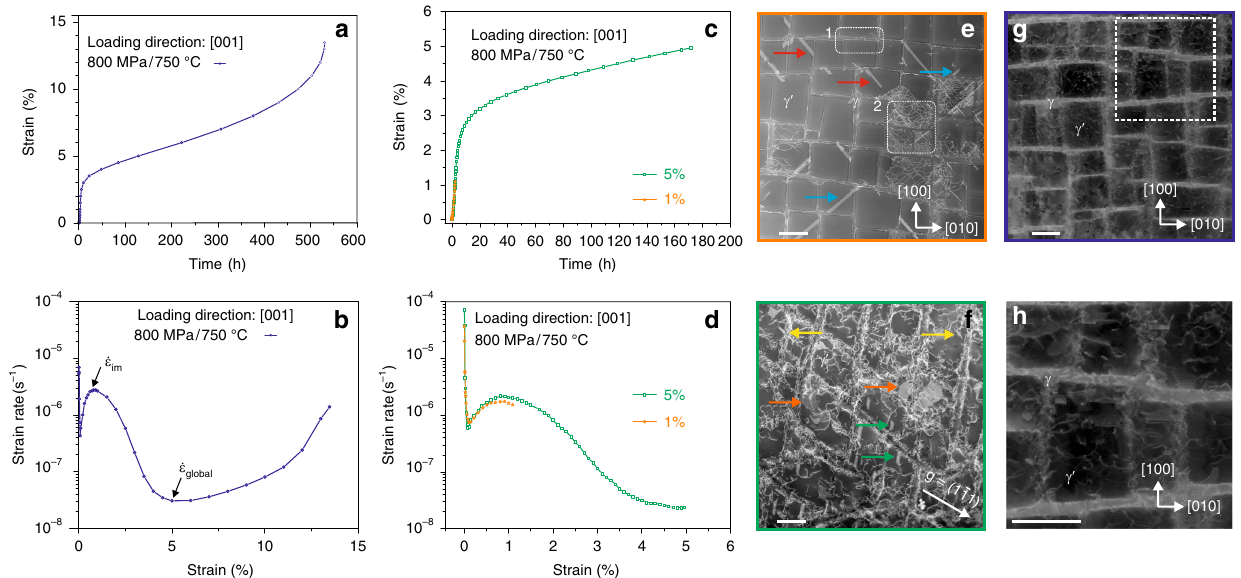
Fig. 1 Creep curves and microstructures for ERBO-1. Creep condition: 750 °C, 800 MPa, [001] orientation. a Strain vs. time till rupture. Rupture time: ~530 h. b Strain rate vs. strain till rupture. c Interrupted creep curves at 1 and 5%, strain vs. time. 1% creep time: ~1 h. 5% creep time: ~170 h. d Interrupted creep curves at 1 and 5%, strain rate vs. strain. e Representative STEM ADF overview of 1% creep strain, viewed in [001] zone axis. Region 1: region with low dislocation density; region 2: region with high dislocation density. Blue and red arrows show two types of SFs. f Representative STEM ADF overview of 5% creep strain under ( g ) condition of 1 (cid:2) 11 ð Þ , showing three different types of SFs, pointed by yellow, orange and green arrows. g ECCI overview of ruptured sample showing dislocations in the γ channel and SFs in the γ ′ phase. h Enlarged view from the rectangle in ( g ). Scale bar is 500